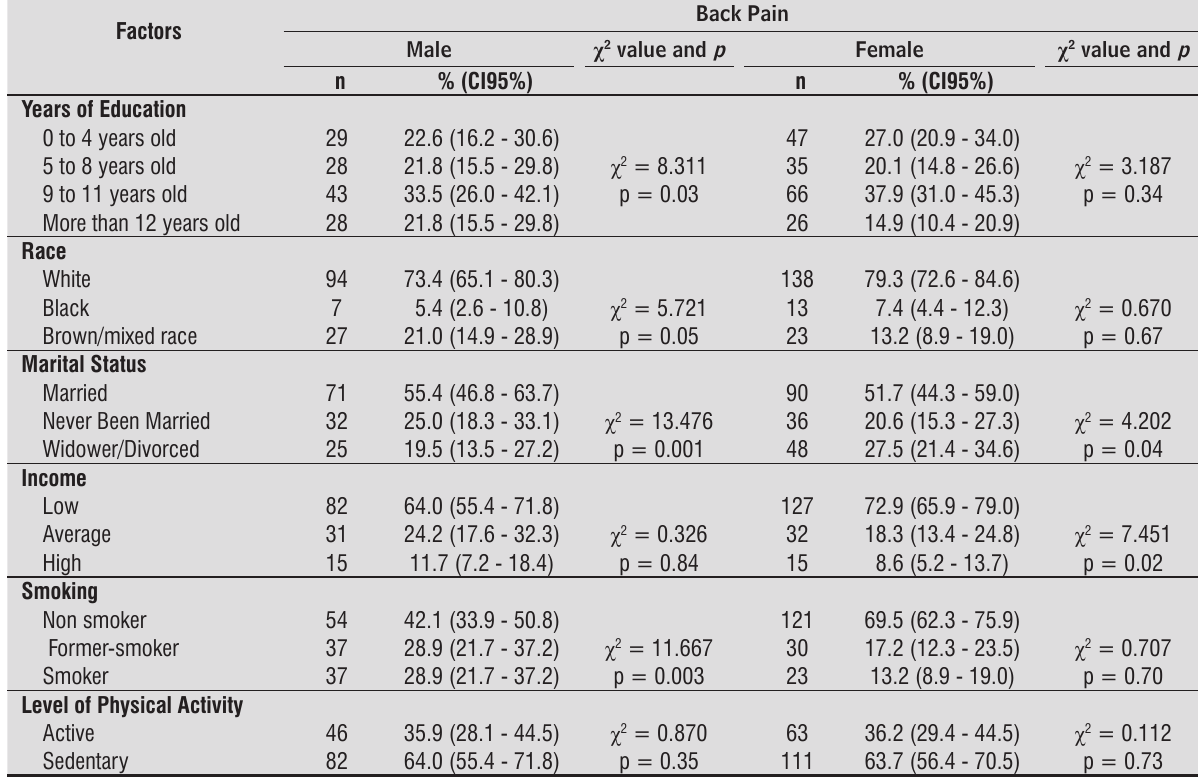
Table 2 - Bivariate analysis between sociodemographic characteristics – smoking and physical activity level and pain in spine – from subjects over 20 years old, living in the city of Bauru (São Paulo, Brazil), by gender